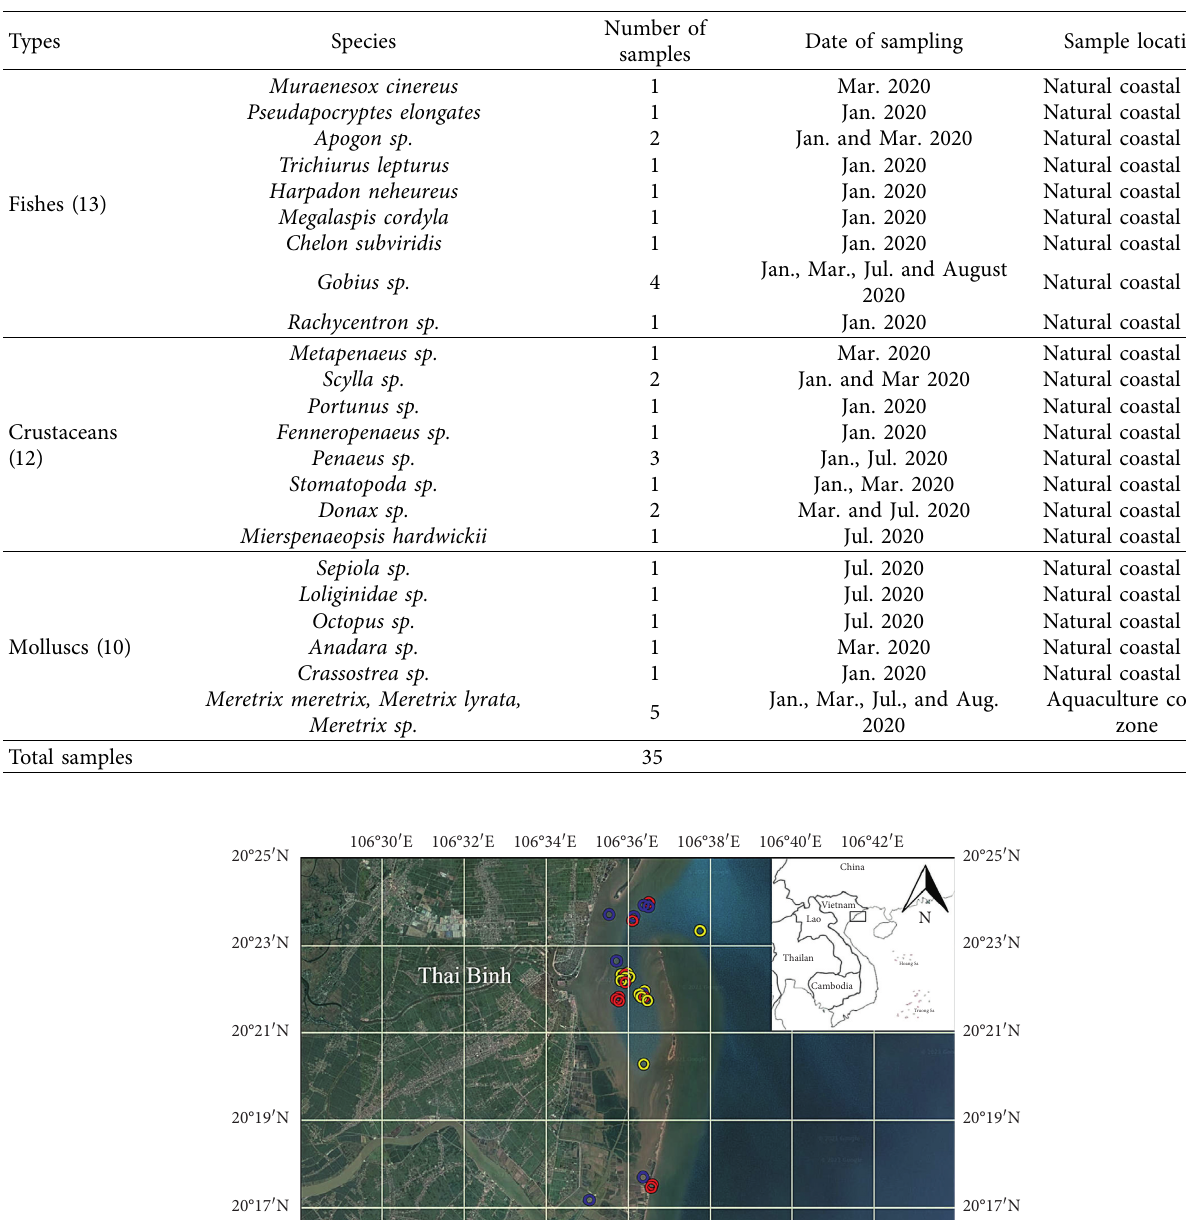
Table 1: Sampling sites and sample information.